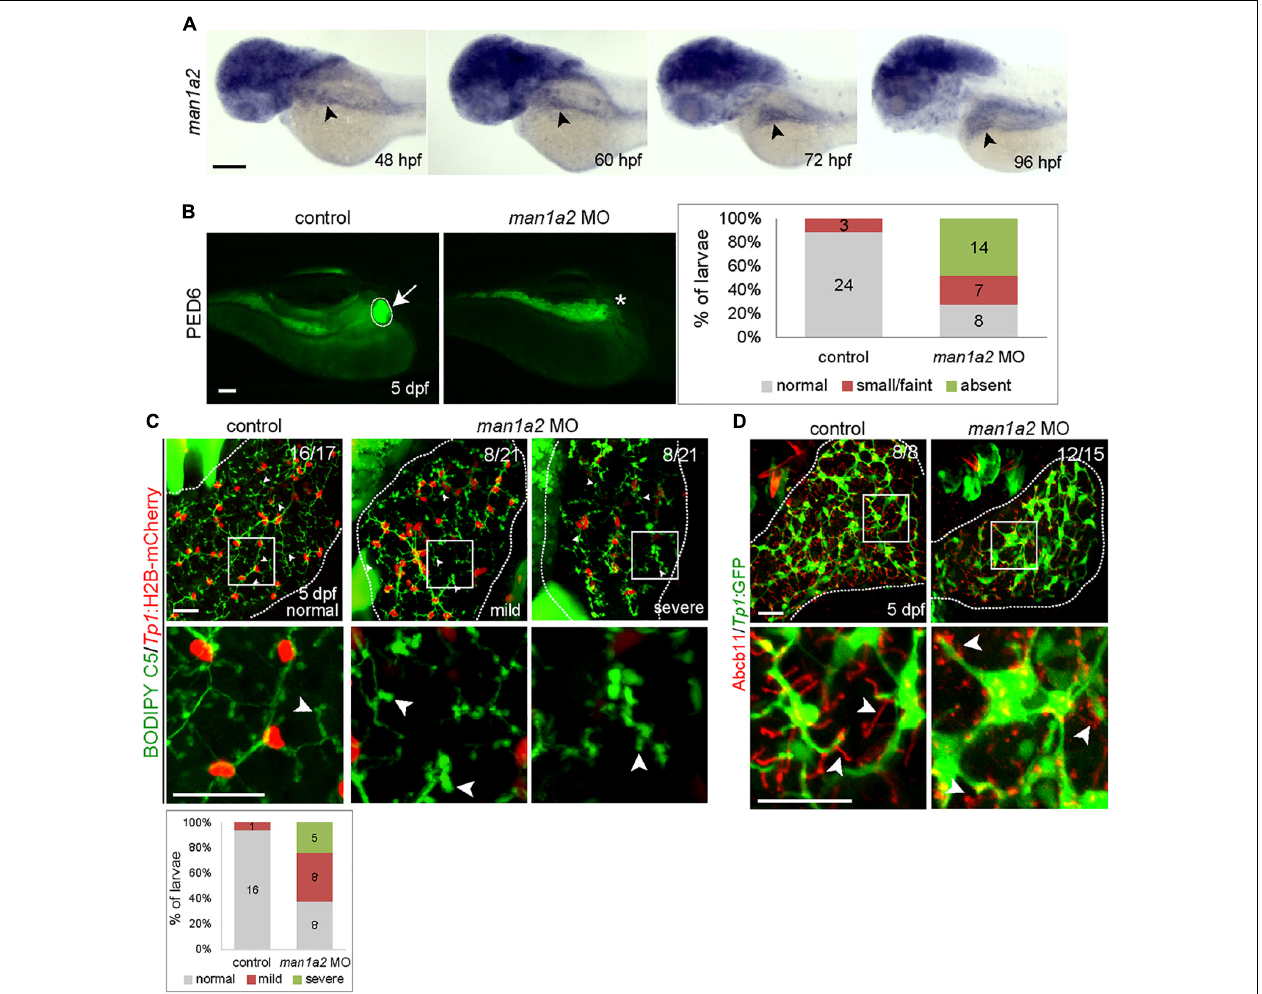
FIGURE 2 | man1a2 knockdown results in developmental biliary defects in zebrafish. (A) Whole-mount in situ hybridization image showing man1a2 expression in developing embryos/larvae. Arrowheads point to the liver. (B) Epifluorescence images showing PED6 accumulation in the gallbladder. The arrow points to the gallbladder outlined by a dotted line; the asterisk denotes gallbladder location. Based on PED6 levels in the gallbladder, larvae were divided into three groups: normal, small/faint, and absent. Graph showing the percentage of larvae in each group. Numbers in the graph indicate the number of larvae in each group. (C) Confocal images of the liver showing the intrahepatic biliary network, as revealed by BODIPY C5 labeling (green, biliary ductal network) and Tp1 :H2B-mCherry (red, BEC nuclei) expression. Based on the severity of biliary defects, larvae were divided into three groups: normal, mild, and severe. Higher magnification images of the square regions are also shown. Dotted lines outline the liver Graph shows the percentage of larvae in each group. Numbers in the graph indicate the number of larvae in each group. Arrows point to bile canaliculi; dotted lines outline the liver. (D) Confocal images of the liver showing the expression of Tp1 :GFP (green) and Abcb11 (red) for biliary structure and hepatocyte bile canaliculi, respectively. Higher magnification images of the square regions are also shown. Arrows point to bile canaliculi; Dotted lines outline the liver. Numbers in the upper right corner are the fraction of larvae exhibiting the representative phenotype shown. Scale bars: 100 (A,B ), 25 (C,D) µ